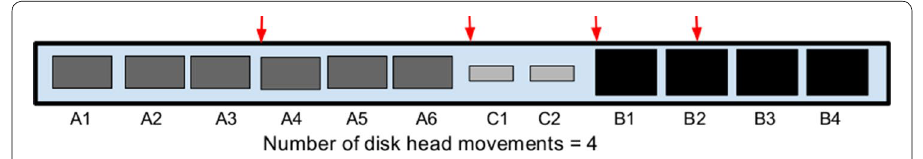
Fig. 7 Working of an Ideal Scheduling